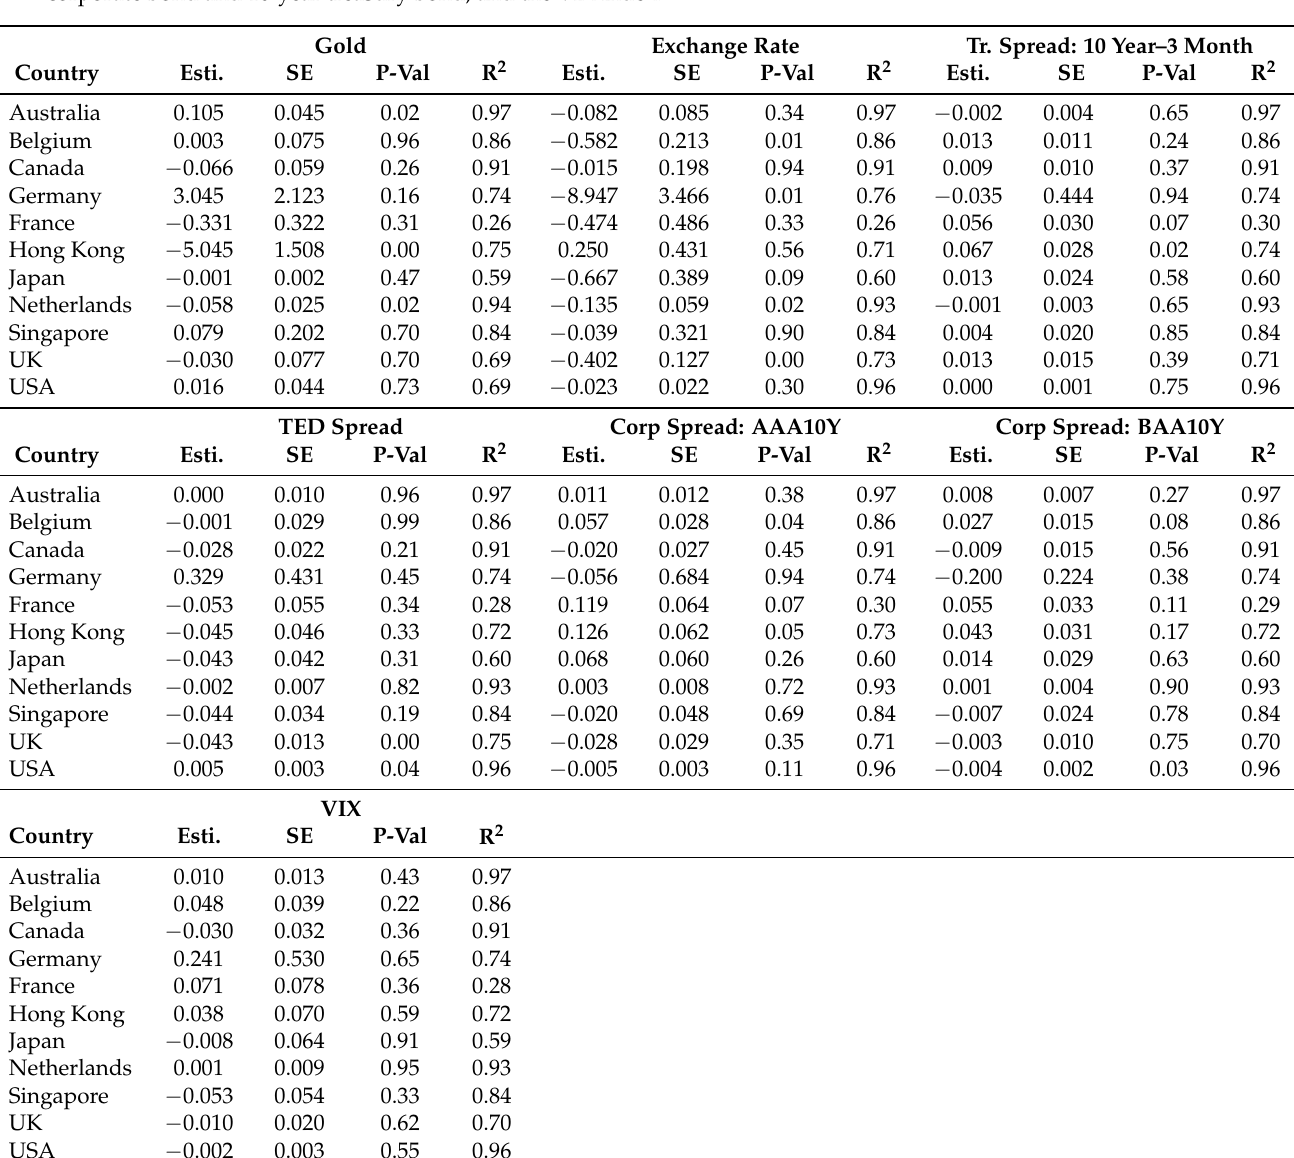
Table 3. The US financial market conditions and time-varying impact of federal funds shocks. The table presents the impact of the US financial market conditions on time-varying response of international REITs to federal funds shocks using the OLS model. Given the construction of the TVP model, each regression includes a lag of the dependent variable and a constant. The financial market condition measures include changes in gold prices, exchange rates, US treasury spread between 10-year and 3-month maturity, TED spread, spread between AAA corporate bond and 10-year treasury bond, spread between BAA corporate bond and 10-year treasury bond, and the VIX